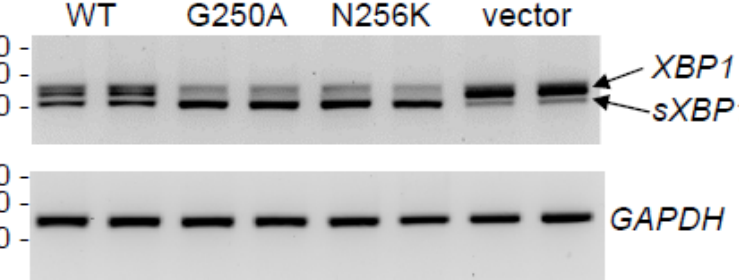
Figure 2. Effect of the p.G250A CPA1 variant on endoplasmic reticulum stress markers in transfected HEK 293T cells. For comparison, the effect of wild-type CPA1 (WT), the reference pathogenic mutation p.N256K, and empty expression vector were studied. ( A ) Expression of HSPA5 (BiP) mRNA measured by RT-qPCR. ( B ) Expression of DDIT3 (CHOP) mRNA measured by RT-qPCR. ( C ) Splicing of XBP1 mRNA (sXBP1) assessed by RT-PCR and agarose gel electrophoresis. GAPDH mRNA was measured as a loading control. Representative gel from three experiments is